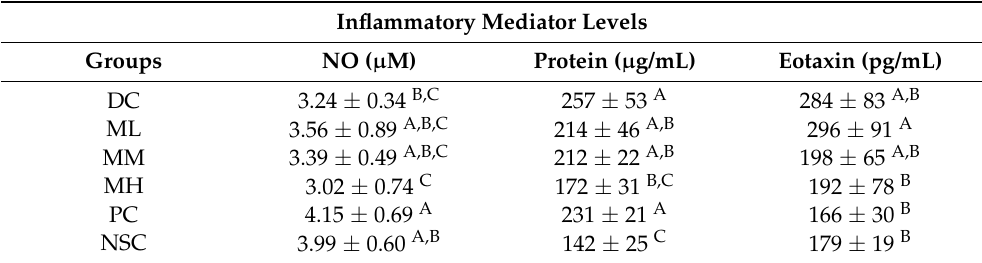
Table 2. Effects of menthone inhalation with different doses on inflammatory mediator levels in the BALF of OVA/Al-sensitized and challenged BALB/c asthmatic mice.